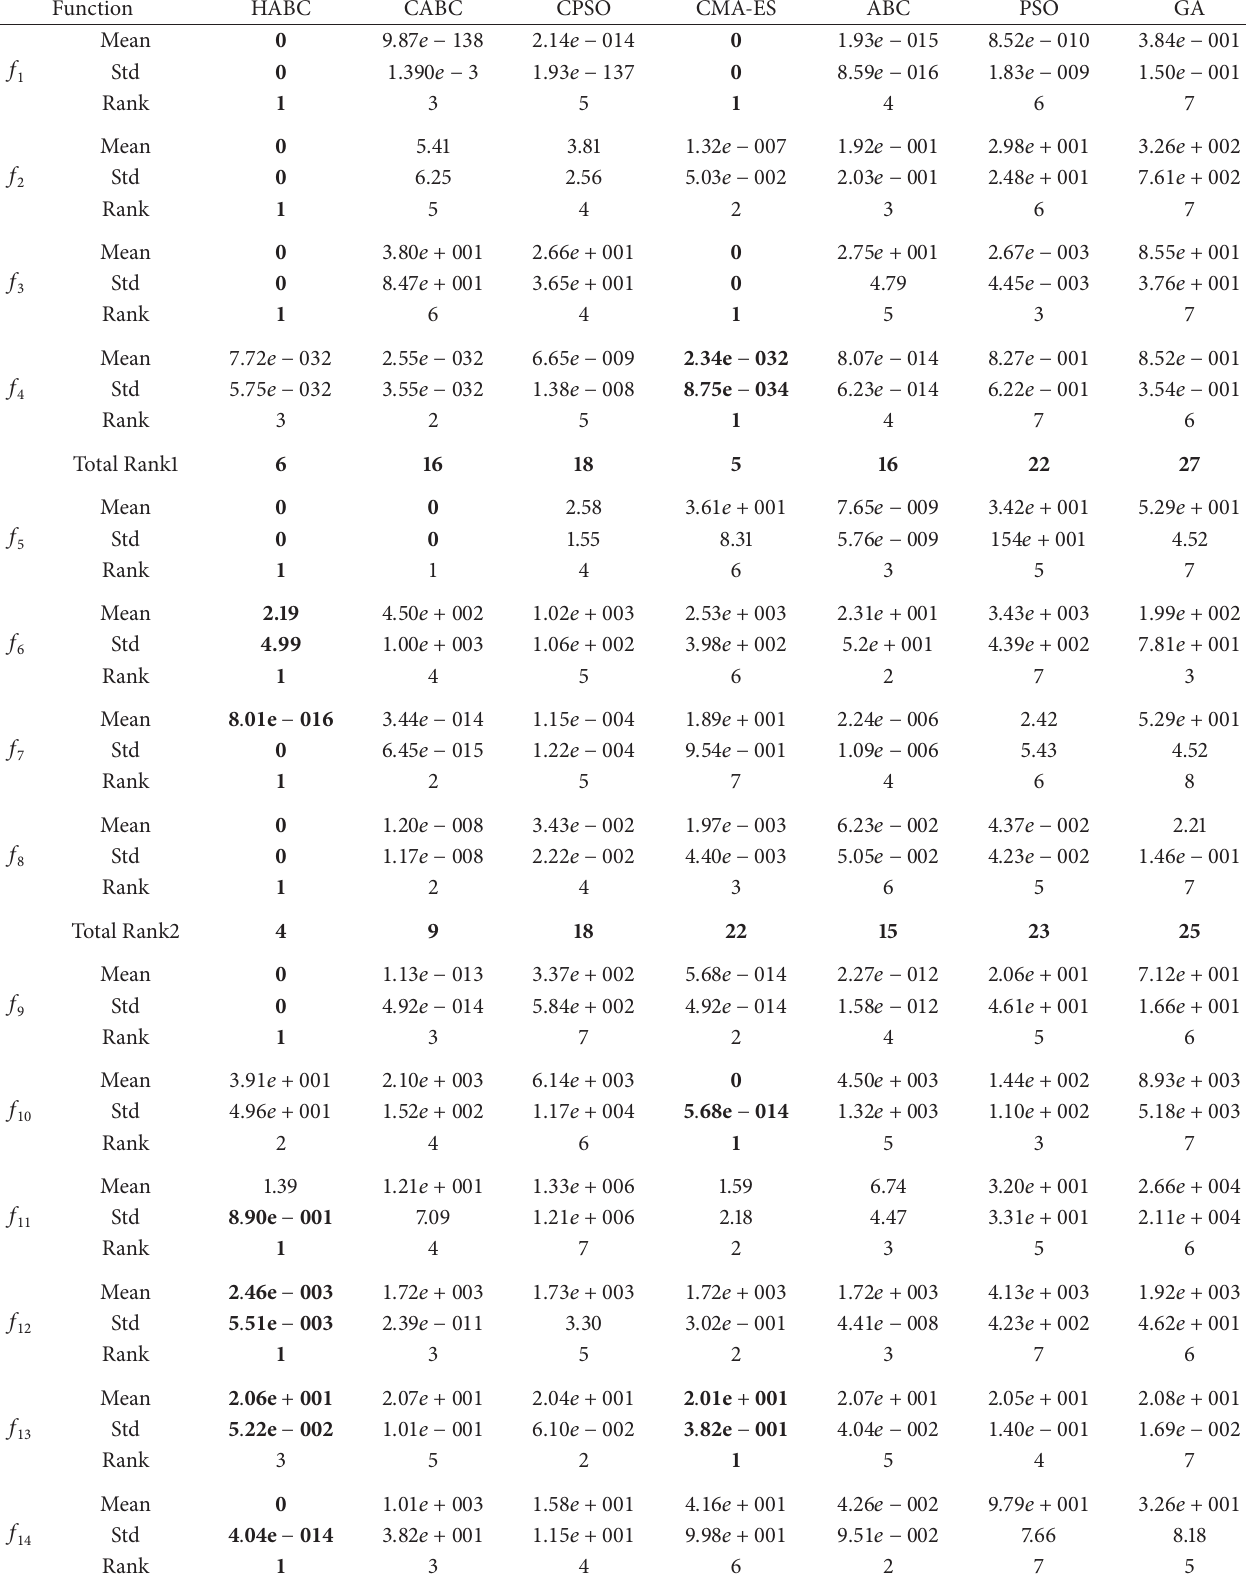
Table 7: Performance of all algorithms on benchmark continuous functions 𝑓 1 – 𝑓 15